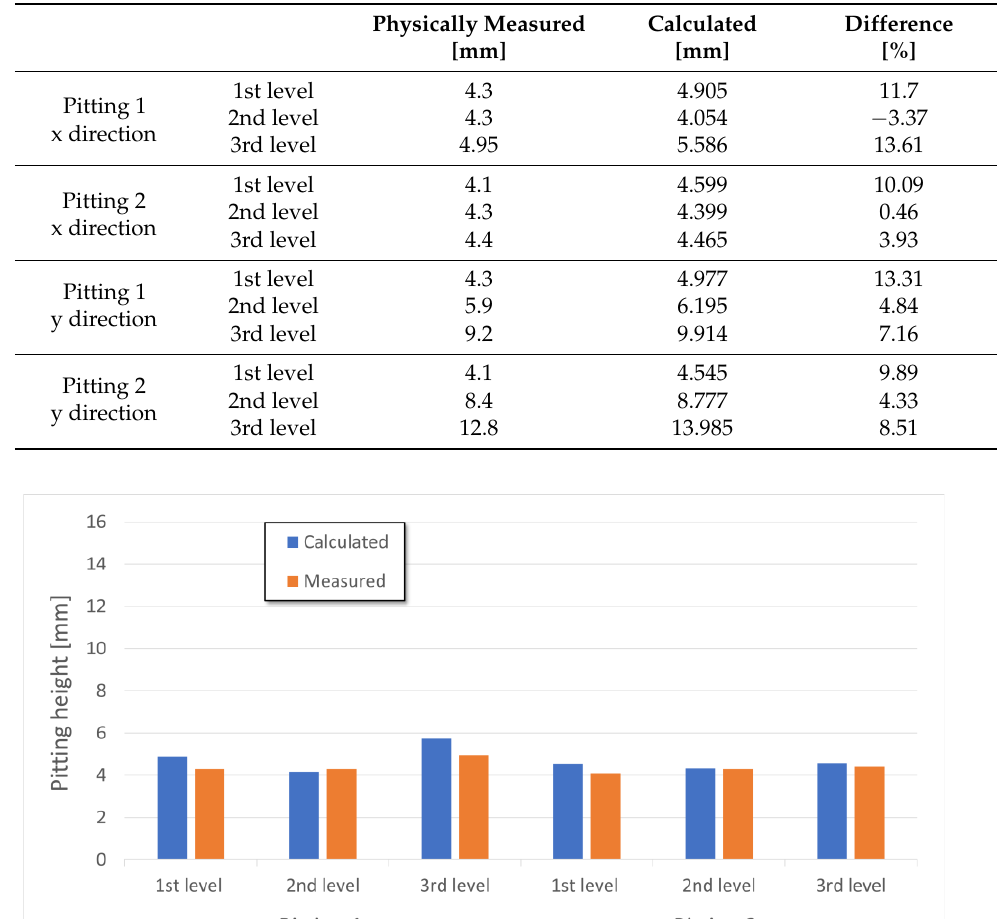
Table 2. Difference between the measured and the calculated size of pitting damage for Pitting 1 and 2.